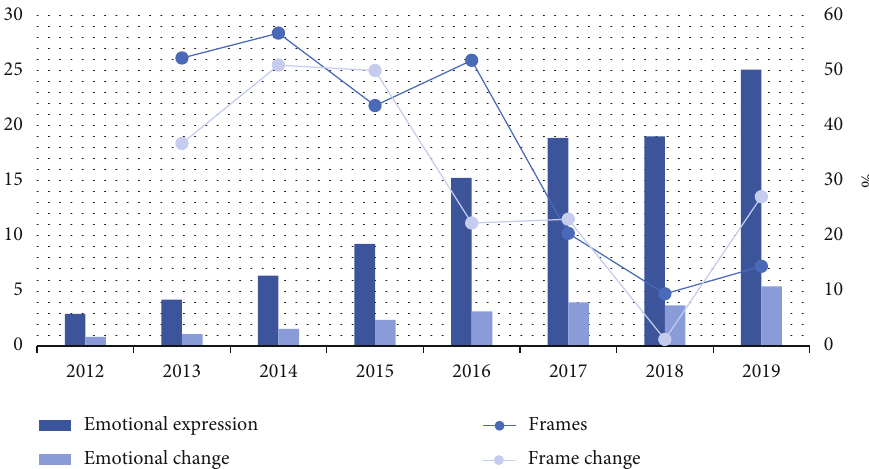
Figure 4: Summary of natural elements in animation works.